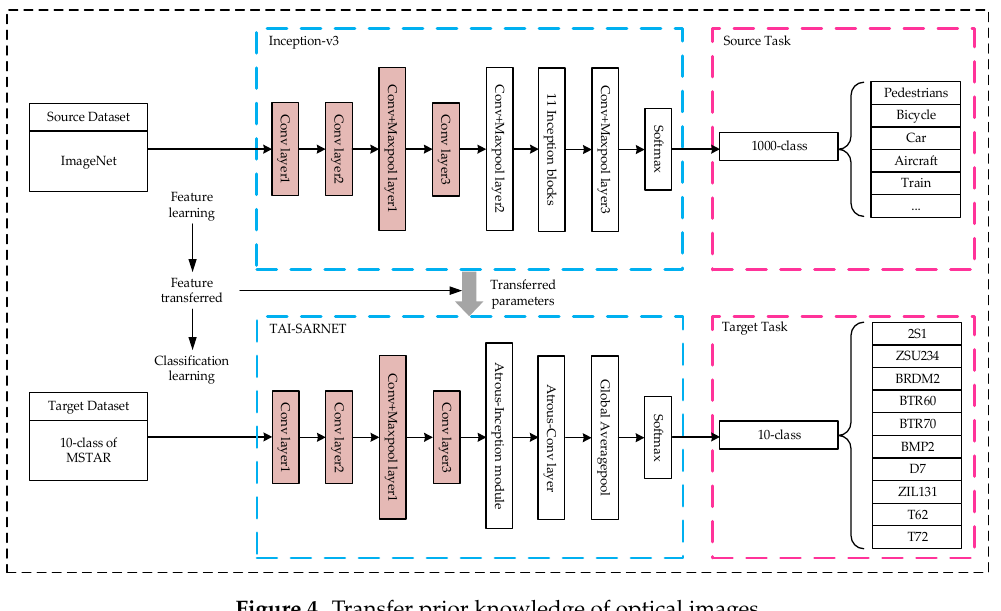
Sensors 2020 , 20 , x FOR PEER REVIEW Figure 4. Transfer prior knowledge of optical images. Figure 4. Transfer prior knowledge of optical images.